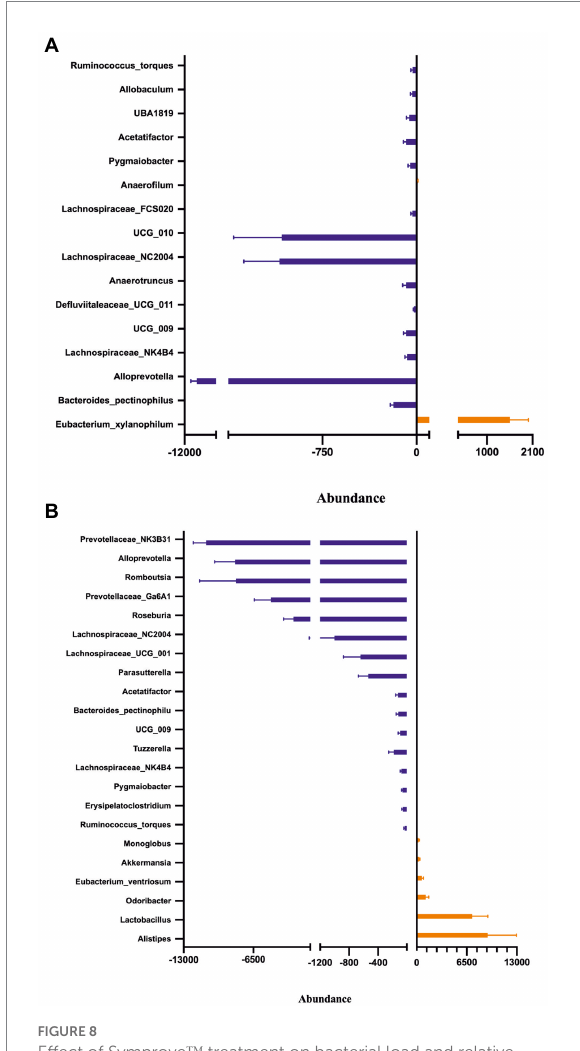
FIGURE 8 Effect of Symprove ™ treatment on bacterial load and relative abundance at genus level. Comparison of relative abundance between Sham + Placebo and Model + Placebo groups (A) and between Model + Placebo and Model + Symprove ™ groups (B) . Only genus differing significantly between the groups were reported, further details are included in Supplementary Tables 1,